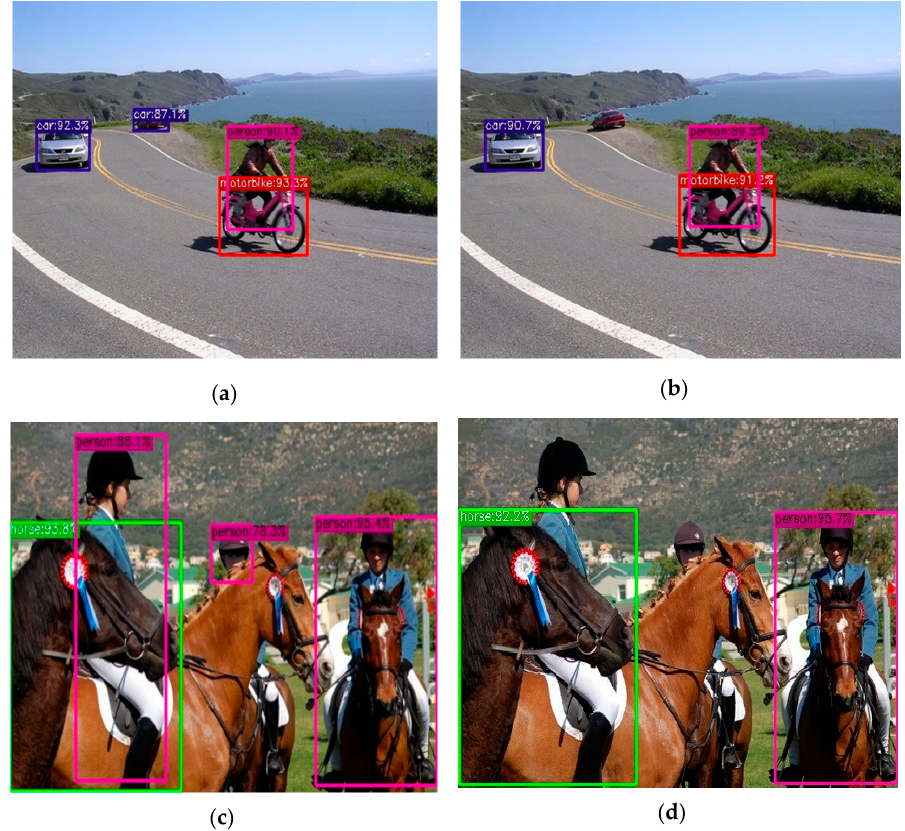
Figure 8. The AP comparison chart of EYOLOX training PASCAL VOC 07+12 on the validation set. The blue curve represents the result of iteration 165 epochs, and the red curve represents the result of iteration 300 epochs.